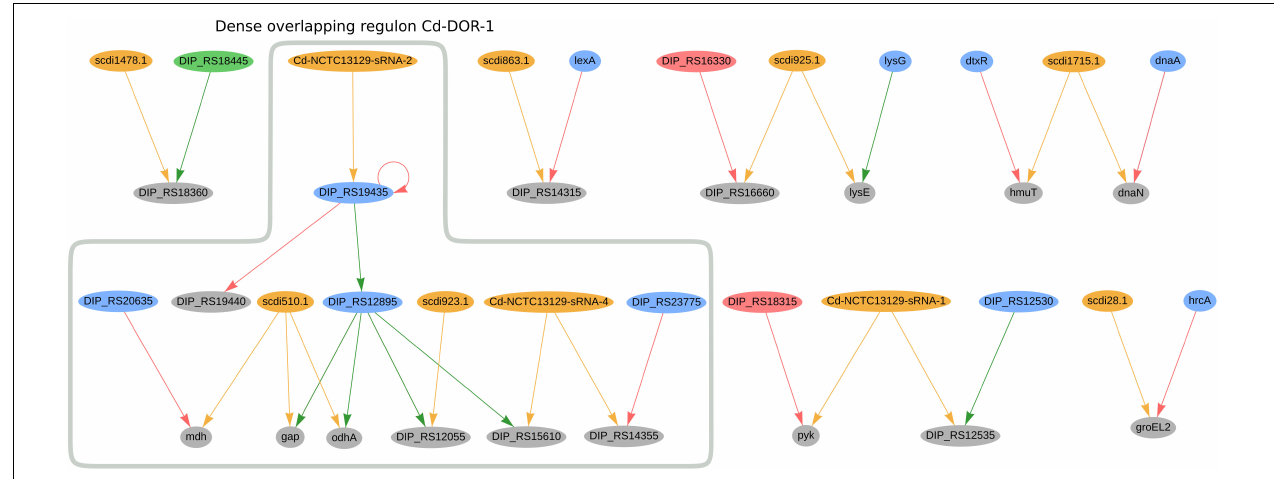
FIGURE 5 | Genes regulated by sRNAs and regulatory proteins in C. diphtheriae NCTC 13129. In the network, green nodes represent activator proteins, red nodes represent repressor proteins, blue nodes represent dual regulators (i.e., that can activate and repress gene expression), orange nodes represent sRNAs and gray nodes represent target genes. The arrows represent the regulatory interactions and their colors represent the same roles as the ones in the nodes.